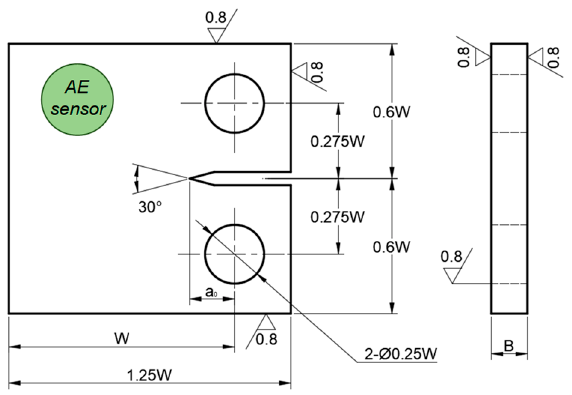
Figure 1. The schematic illustration of the CT specimen and position of the AE sensor.